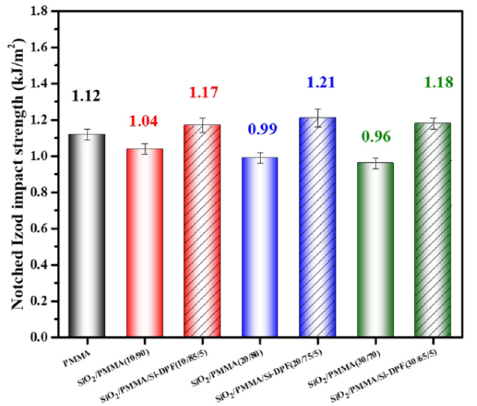
Figure 6. Impact strengths of the PMMA matrix and SiO 2 /PMMA composites.